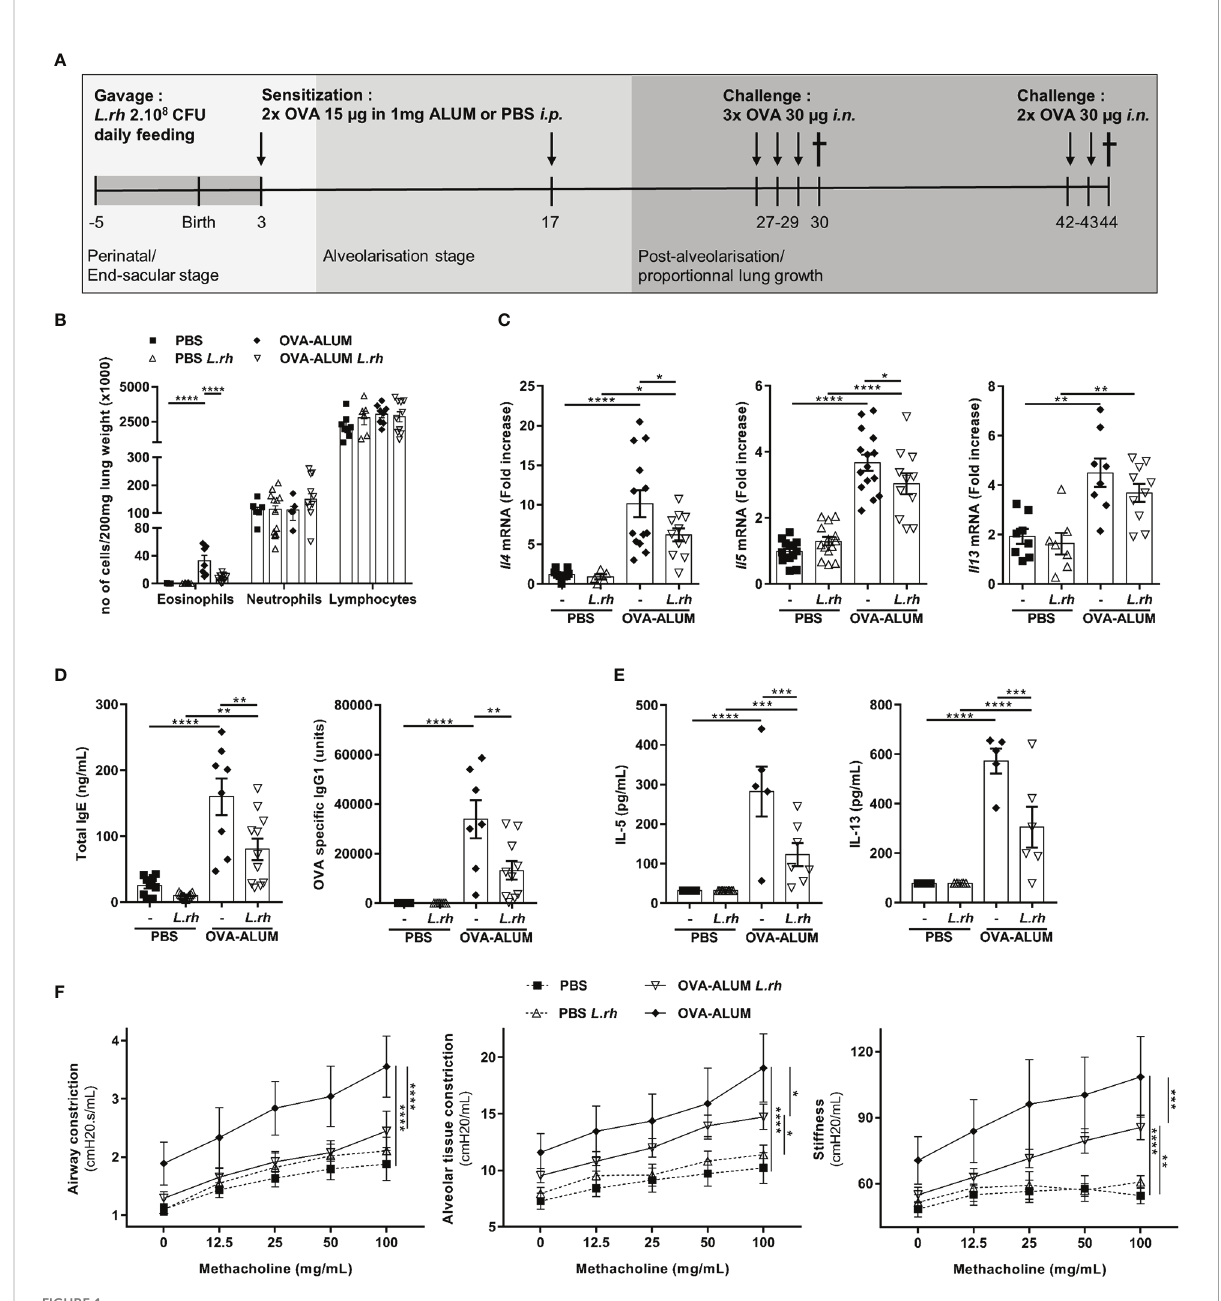
FIGURE 1 Perinatal L.rhamnosus exposures protects neonates from OVA-ALUM induced airway allergic reaction. (A) Protocol of airway allergic in fl ammation induction. Neonates born from C57BL/6 control (-) or probiotic-supplemented mother ( L.rh ) were mock-sensitized i.p. with PBS or with 15 µg OVA in 1 mg ALUM on postnatal day (PND) 3 and 17 and were challenged with 30 µg OVA on 3 consecutive days 10 days after the last sensitization. For fl exiVent © experiments, neonates were challenged again for 2 consecutive days with 30 µg OVA 2 weeks later. Mice were sacri fi ced on PND30 for the immunological analysis (B – E) and PND44 to assess the respiratory functions (F) . (B) Cell counts in the lung were determined 24h after the last challenge by fl ow cytometry (FACS). (C) Pulmonary mRNA normalized expression of Il4 , Il5 and Il13 were analyzed by quantitative RT-PCR (qRT-PCR). Relative unit was obtained by comparing each group to the mean of non-treated PBS mice. (D) Total IgE and OVA-speci fi c IgG1 in serum were quanti fi ed by ELISA. (E) Th2-associated cytokines in MLN restimulated for 3 days with 100 µg/mL OVA grade V were measured by ELISA. (F) AHR in response to increasing doses of methacholine was analyzed by fl exiVent © system. Results are a pool of 3 – 4 independent experiments and are shown as mean ± SEM. Statistical analysis was done using an ordinary one-way ANOVA (Holm-Sidak ’ s multiple comparisons test) or a Kruskal-Wallis test (Dunn ’ s multiple comparisons test) (* = p <0.05; ** = p <0.01; *** = p <0.001; **** = p